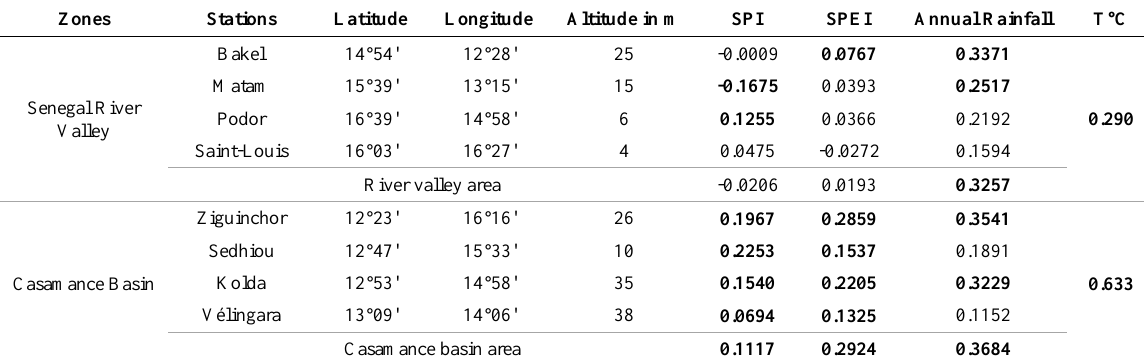
Table 2. Characteristics of the climatic stations selected in the study areas